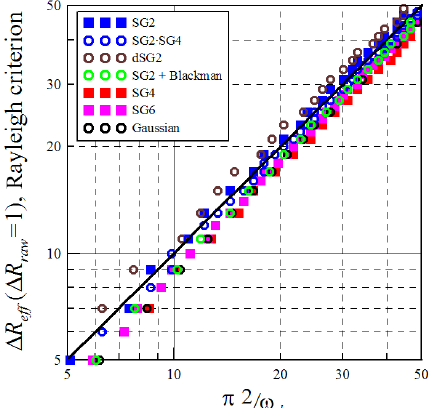
Figure 15. For all the investigated smoothing filters, the ERes ob- tained with the Rayleigh criterion as function of the corresponding ˆ p) value of the quantity π · 2 /ω L ( . The identity line is drawn in sb